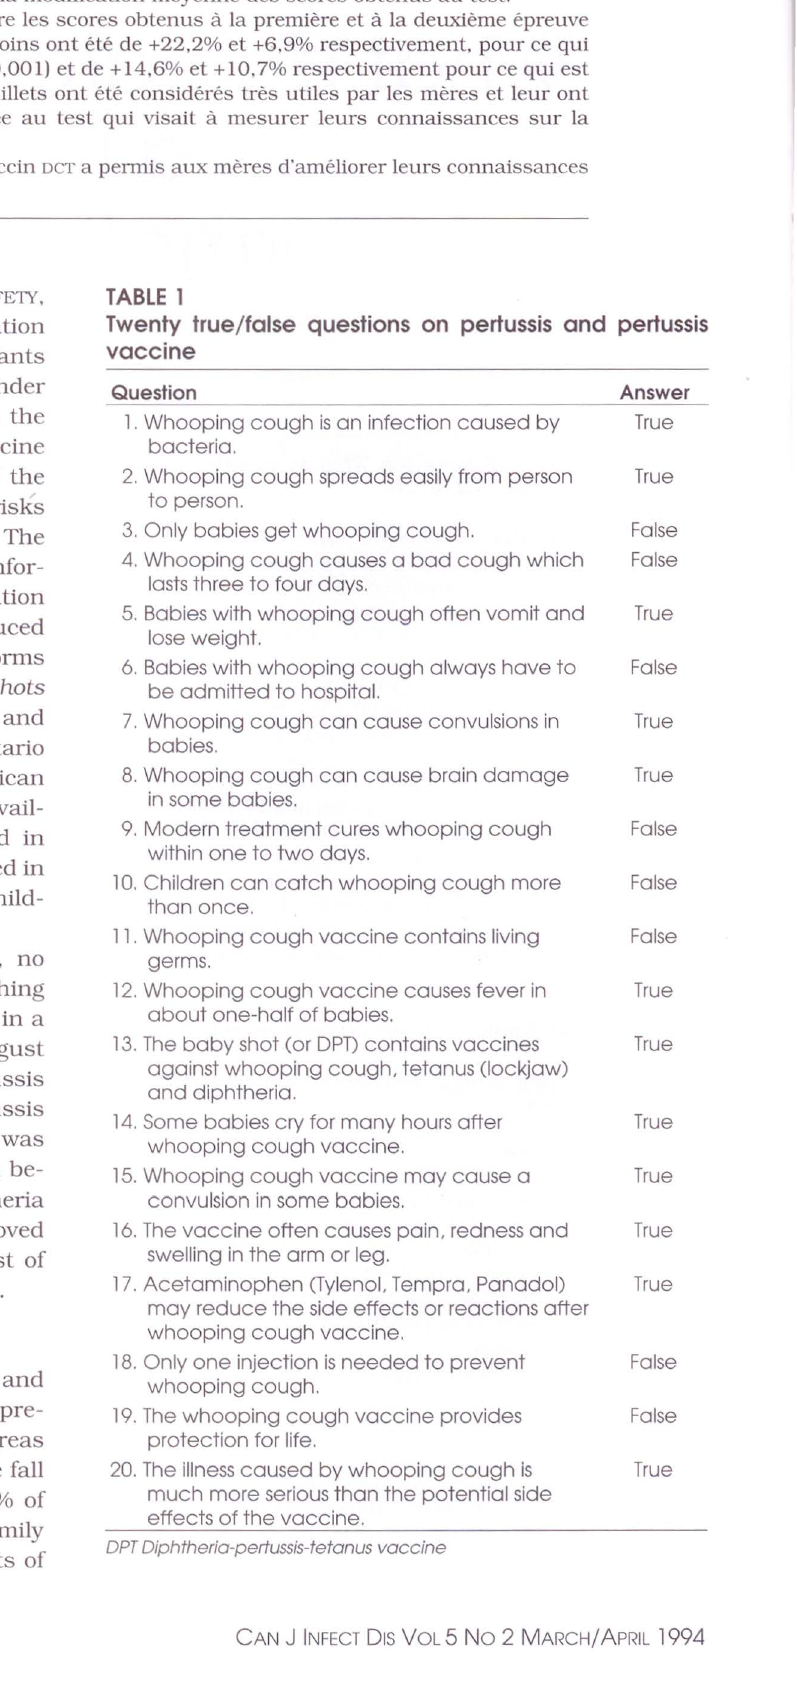
TABLE 1 B ECAUSE OF PUBLIC CONCERN ABOUT VACCINE